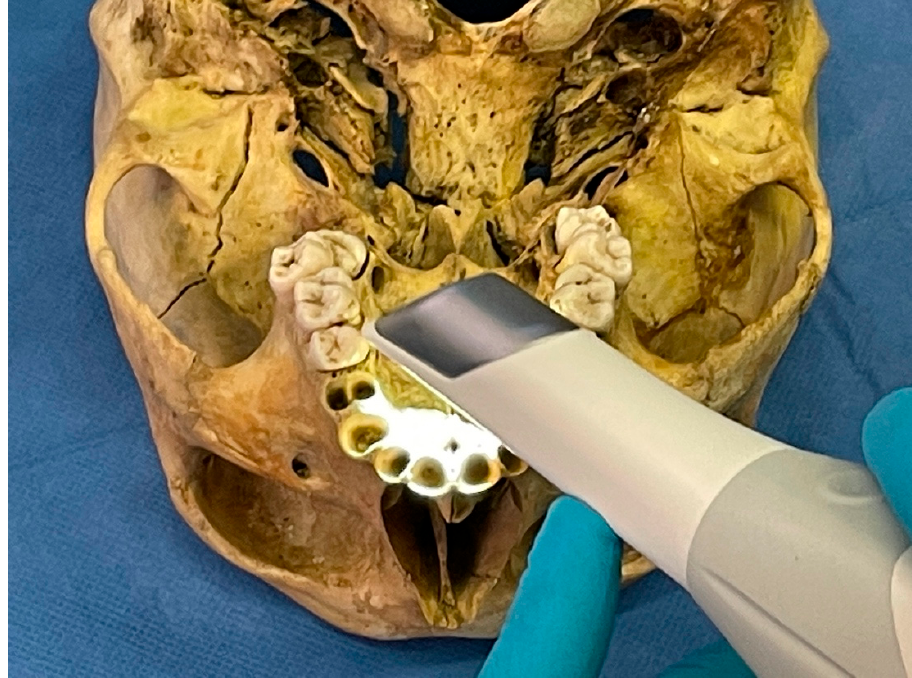
Figure 3. Post-mortem photogrammetry collection of upper dental arch using an intraoral scanner.